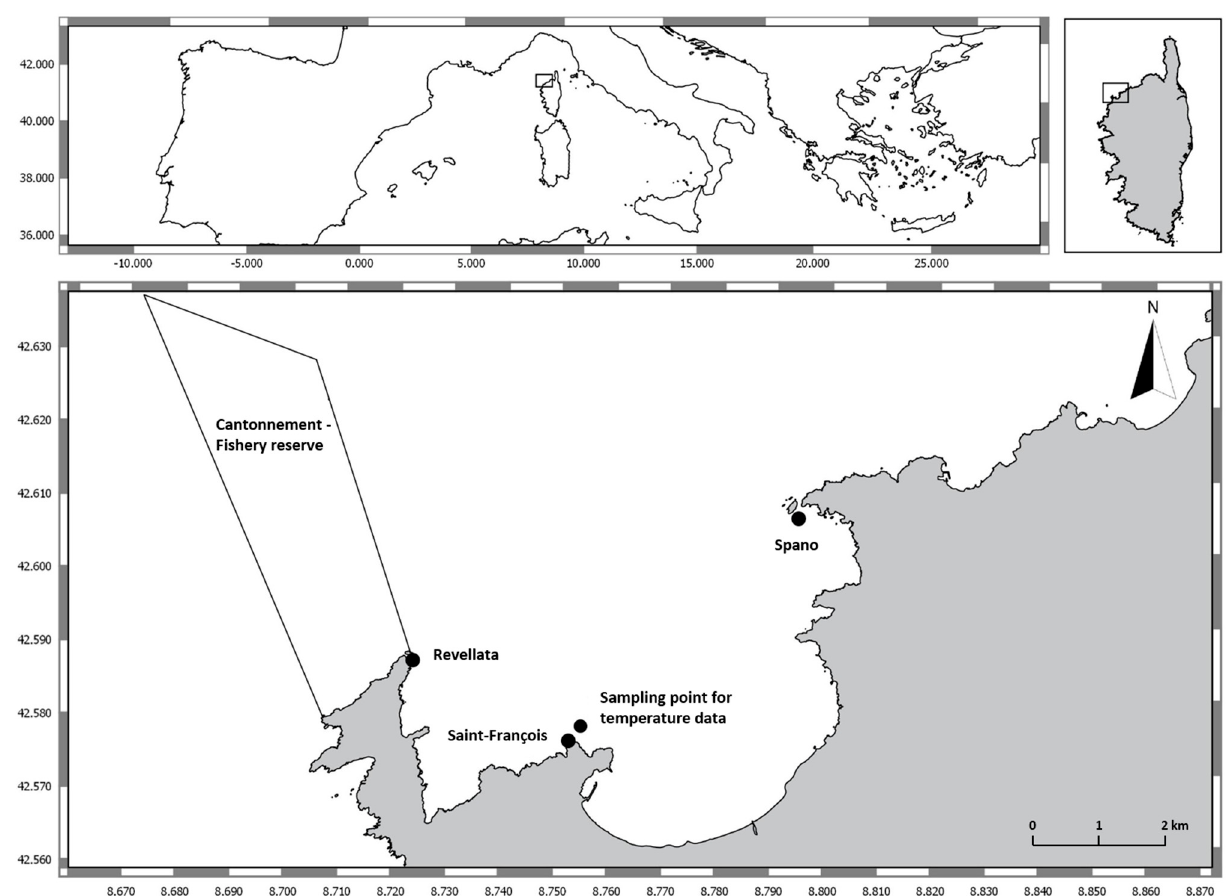
Figure 1. Sampling sites’ locations in the Calvi Bay (Corsica, France): Revellata, Saint-Francois, Spano.